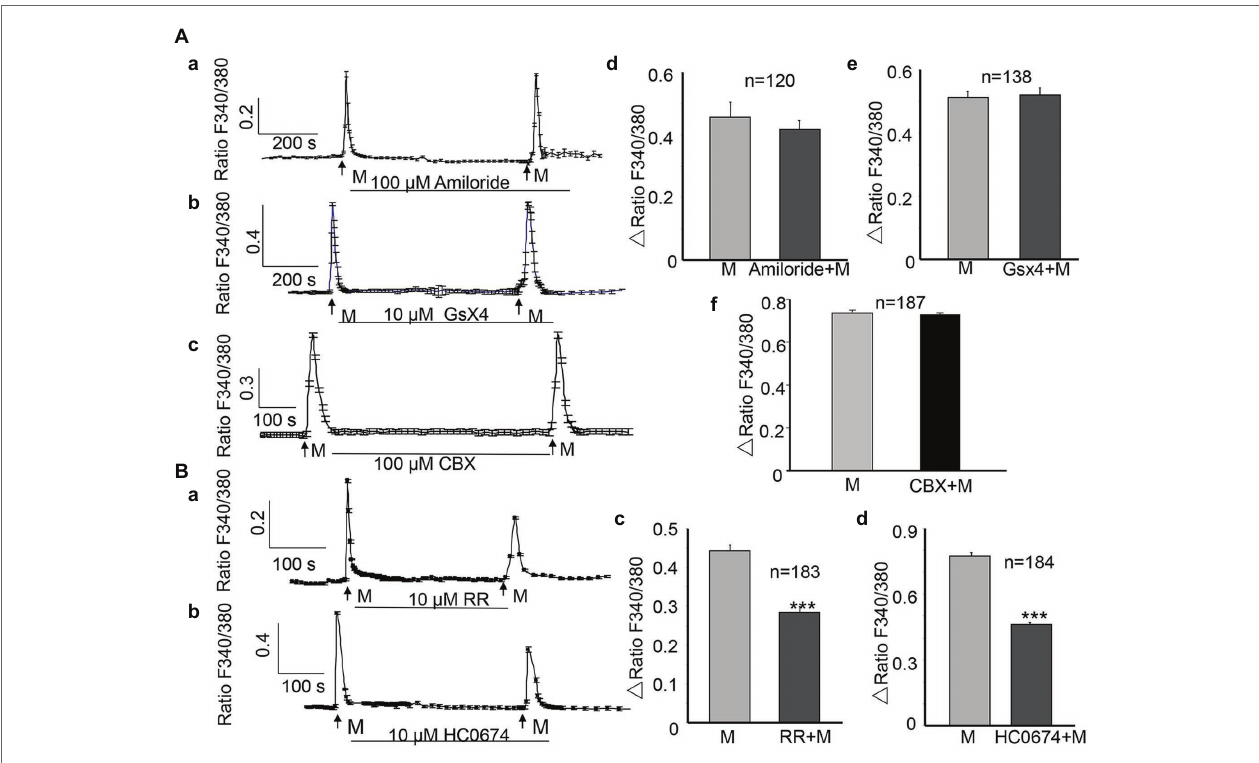
FIGURE 3 | Activation of transient receptor potential vanilloid (TRPV4) channels but not EnaC, Piezo, and connexin channels contribute to the ALI-induced [Ca 2+ ] i increase. (Aa–Ac) Typical traces showing treatment with amiloride (100 μ M), the ENaC channel blocker, GsMTX4 (GsX4, 10 μ M), the Piezo channel antagonist, or carbenoxolone (CBX, 100 μ M), the connexin channel blocker did not attenuate the [Ca 2+ ] i increase. (Ad–Af) Summary data for amiloride ( Ad , n = 120 cells, p > 0.05) and GsX4 ( Ae , n = 138 cells, p > 0.05), and CBX ( Af , n = 187 cells, p > 0.05). (Ba,Bb) Typical traces showing treatment with ruthenium red (RR; 10 μ M), the no- specific cation channel antagonist, and HC0674 (10 μ M), the specific TRPV4 antagonist, reduced the ALI-induced [Ca 2+ ] i increase. (Bc,Bd) Summary data for RR ( Bc , n = 183 cells, p < 0.001) and HC0674 ( Bd , n = 184 cells, p <